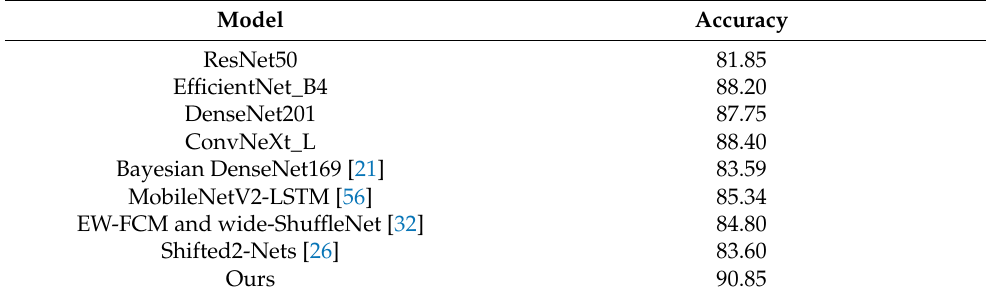
Table 9. The accuracy of each model on the public dataset HAM10000 (test set of 2000 images); the unit is %.